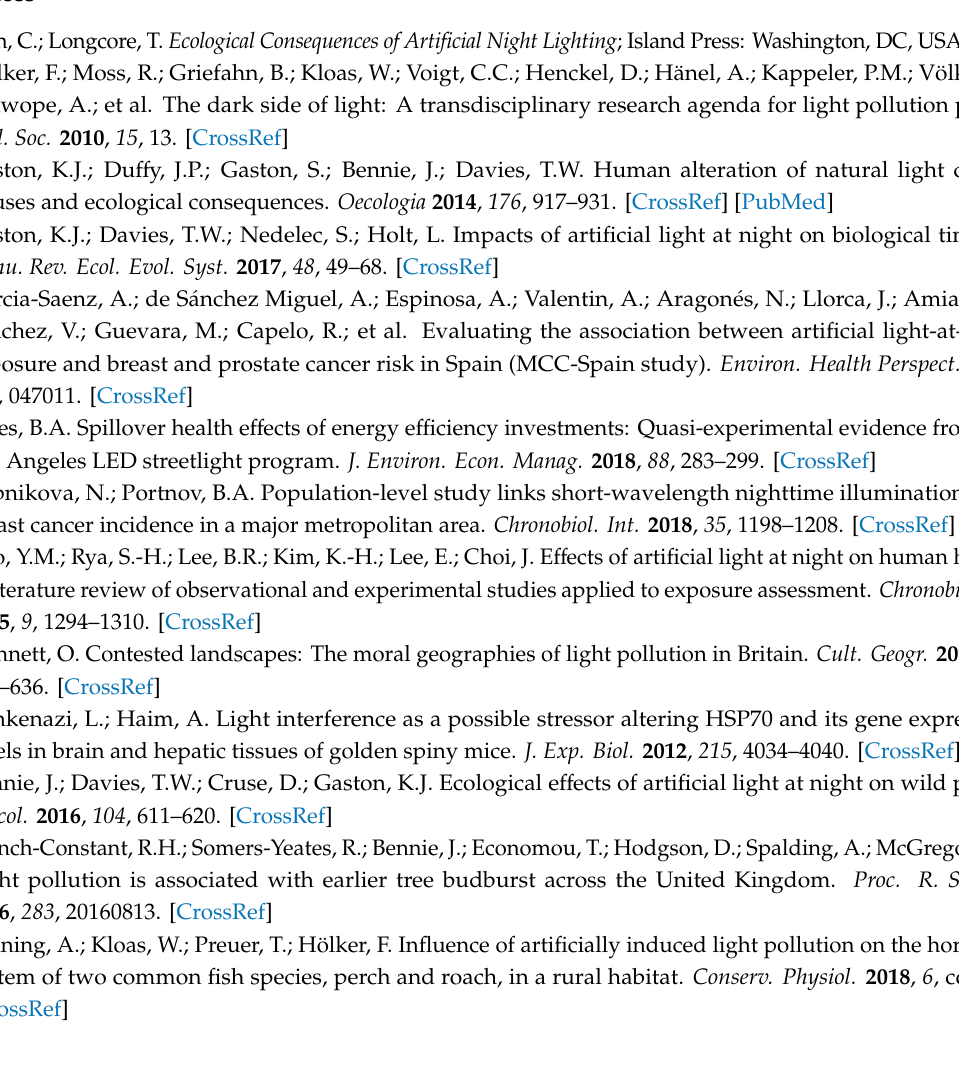
Figure S1: Variation in the coe ffi cient of independent variables for ( a ) light emissions and ( b ) skyglow, Figure S2: Histograms and qqplots of model residuals for ( a ) light emissions, and ( b ) skyglow, Table S1: Relationship between the aggregated classes used here, the landcover map aggregated classes and broad habitat, Table S2: Relative importance of each variable in explaining levels of ( a ) light emissions, and ( b ) skyglow, Table S3: Levels of ( a ) light emissions and ( b ) skyglow inside of National Parks in